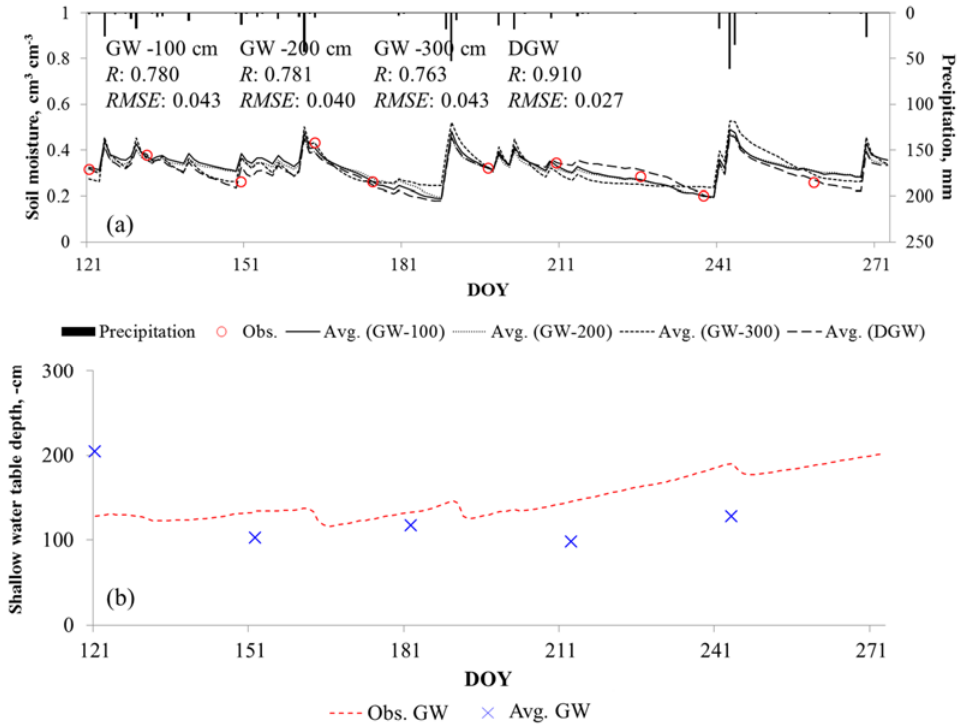
Figure 8. ( a ) Measured (in situ) and ensemble averaged root zone soil moisture; and ( b ) measured and estimated shallow ground water tables by FGW and DGW data assimilation schemes at Bondville site (2003). Number in ensemble: 100.